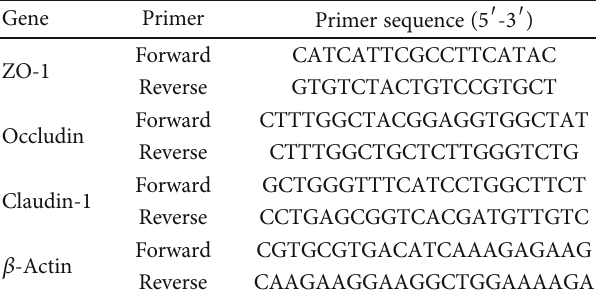
Table 1: Primers used for